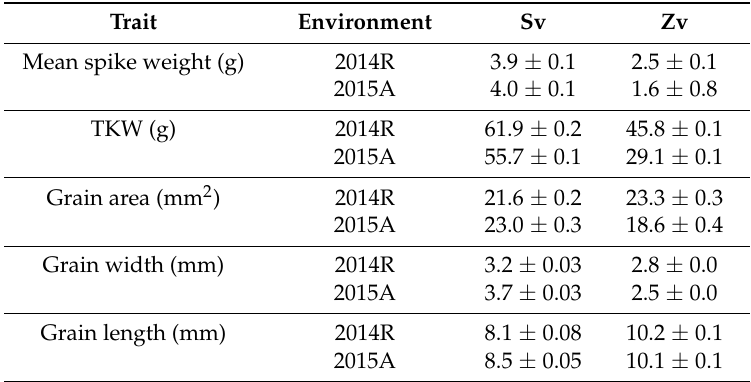
Table 1. Grain parameters of the parental lines Svevo (Sv) and Zavitan (Zv) measured in field experiments 2014R and 2015A (mean ±